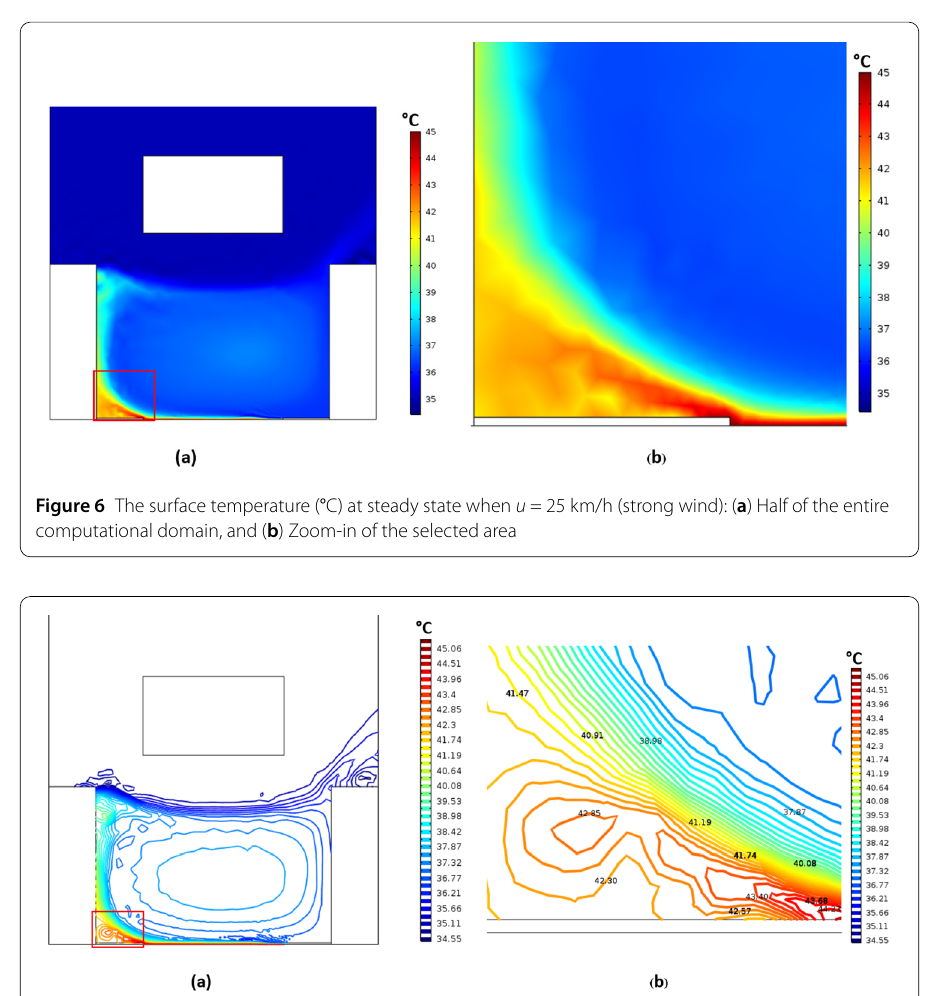
Figure 7 The temperature contour ( ° C) at steady state when u = 7 km/h (gentle wind): ( a ) Half of the entire computational domain, and ( b ) Zoom-in of the selected